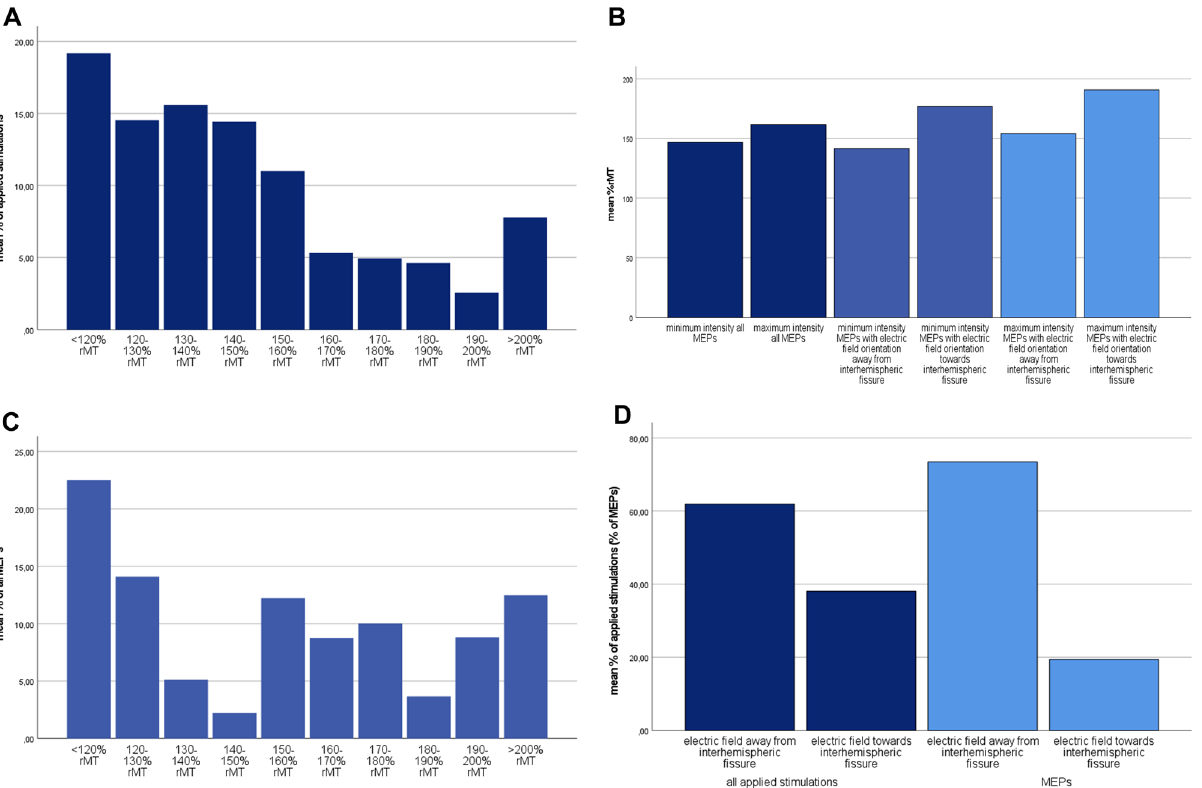
Figure 4. ( A ) Relative amount of applied stimulations at different intensities in the whole patient cohort. Please note that not every patient received stimulations at each intensity step. ( B) Mean intensities at which MEPs were registered: mean lowest intensity, mean maximum intensity, the mean minimum and maximum intensities with different orientations of the electric field. The minimum intensity to elicit MEPs was lower when the electric field was orientated away from the interhemispheric fissure ( p = 0.022). ( C ) Relative amount of MEPs at different stimulation intensities in patients with reproducible MEPs. ( D ) distribution of all stimulations and MEPs at each electric field direction in patients with reproducible MEPs. Total amount of stimulations was not different, whereas the MEP counts showed a significant difference in favor of the main electric field direction pointing away from the interhemispheric fissure ( p =